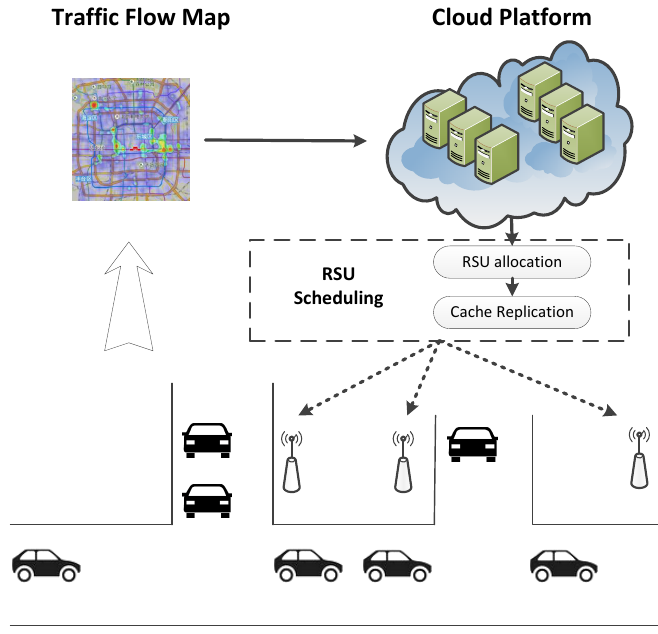
Figure 1. A road segment with a bidirectional